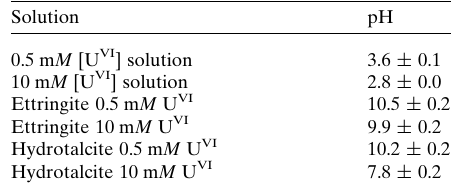
Table 3 pH measurements of uranyl nitrate starting solution and of solutions where uranyl nitrate was mixed with solid cement mineral phases in solution. The errors represent the standard deviation of triplicate